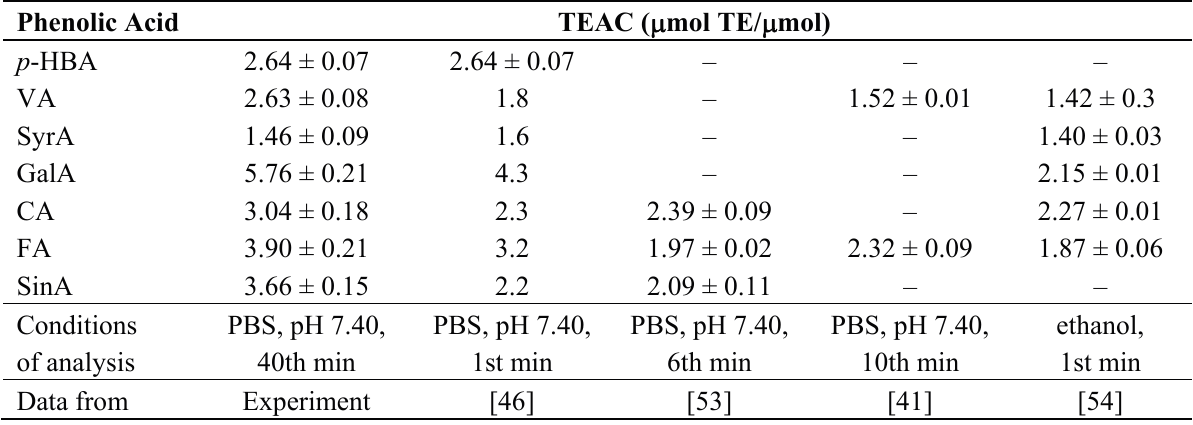
Table 3. Comparison of the experimental AOC of phenyl carbonic acids against the ABTS radical cation with literature